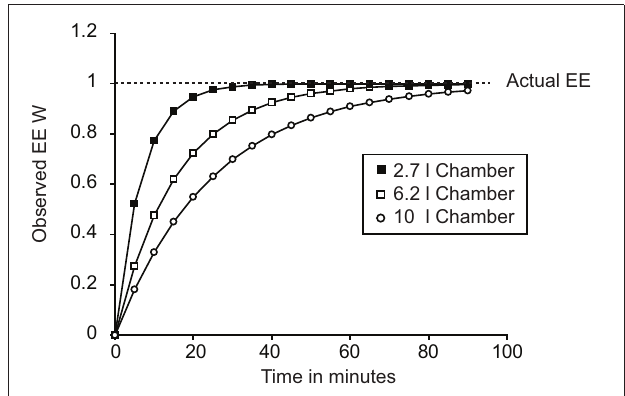
FIGURE 2 | Plot demonstrating the effect of calorimetric lag for different chambers. All cases show the theoretical effect of lag on observed changes in energy expenditure dependent on chamber volume. In all three cases a “mouse” was placed into the chamber at time 0 expending 1W. Chamber volumes of 2.7l, 6.2 l, and 10l correspond to the volumes of a Columbus mouse Oxymax chamber, Columbus CLAMS mouse double-feedercage and the approximate volume of a Tecniplast mouse cage now used in home-cage calorimetry systems.